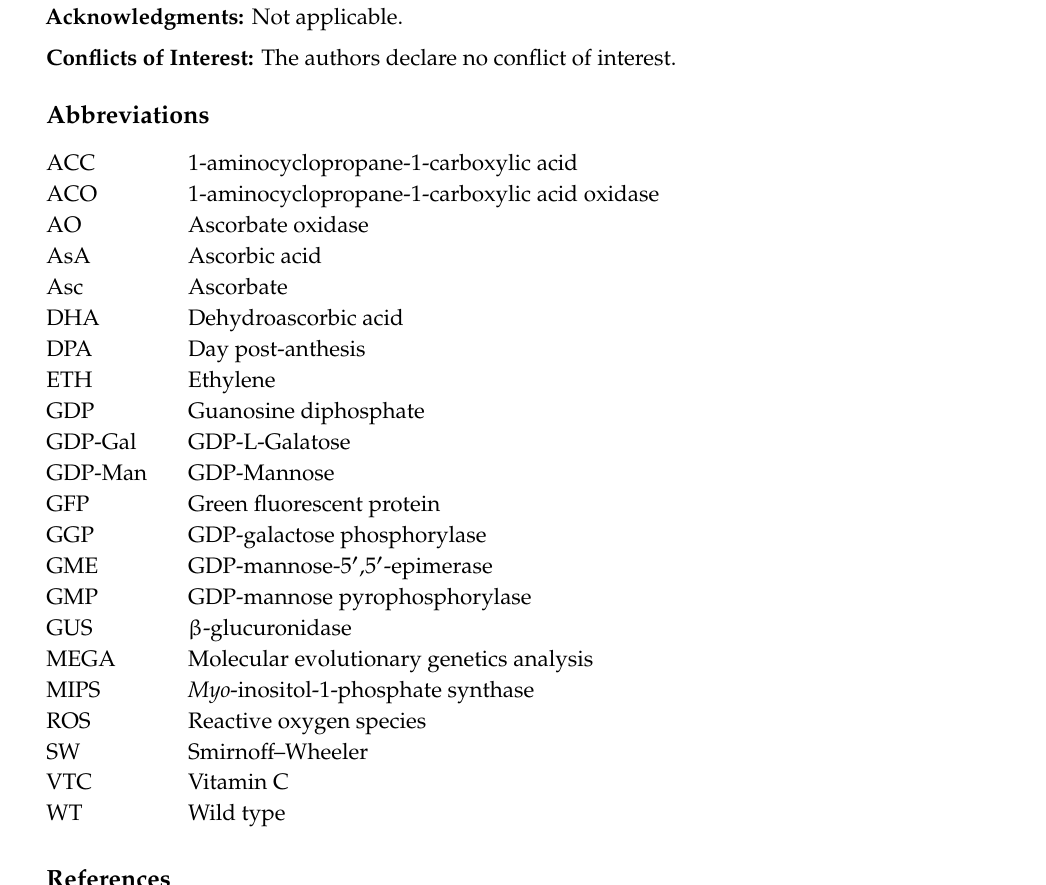
Table S1. Quality check of RNA samples. Table S2. Primers used in this work. Table S3. Putative cis -acting elements in the promoter region of GhVTC1 . Figure S1. Quality check of the RNA samples by electrophoresis detection. Figure S2. Primer detection of GhVTC1 and GhUBQ7 . Figure S3. Phylogenetic tree of GhVTC1 and other plant VTC